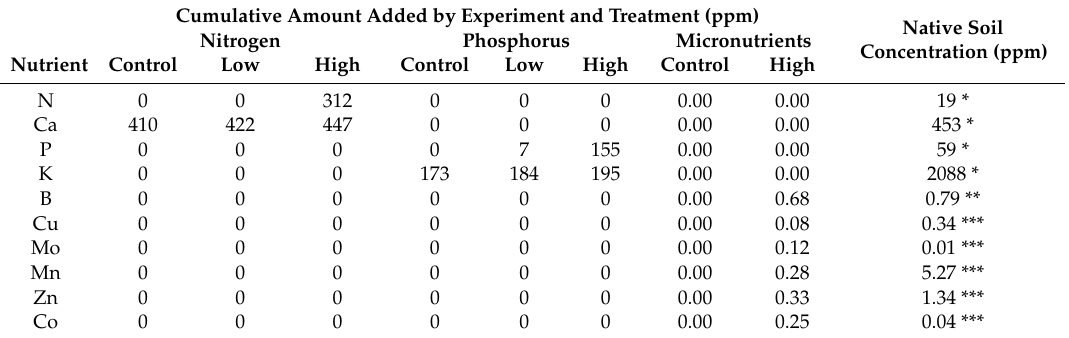
Table 3. Cumulative amounts of nutrients added over the course of the three nutrient experiments, and corresponding native soil concentrations (far right-hand column). Cumulative amounts are expressed per kg of soil in each pot ( µ g nutrient / kg soil =